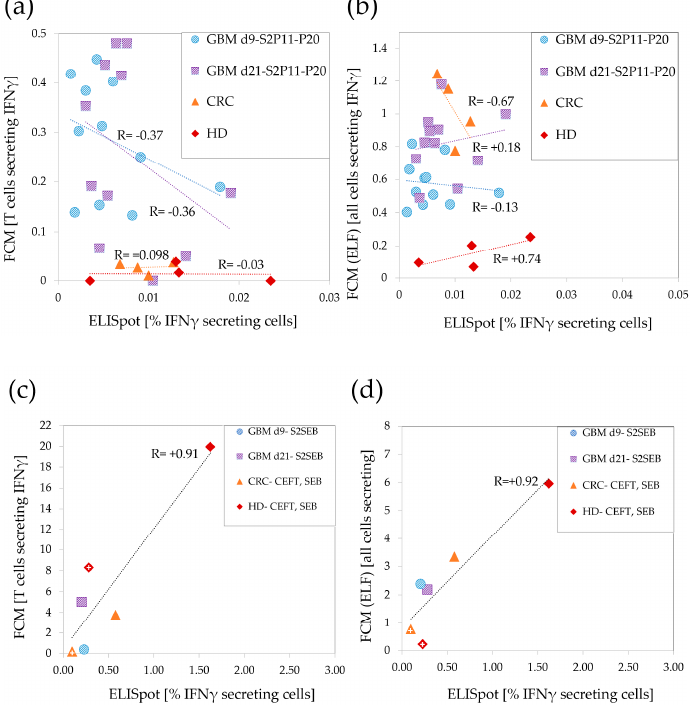
Figure 3. Correlation between ELISpot-measured responses to parallel FCM-measured ones: Responses to peptides in set 2 glioma vaccine (set2 peptides 11–20) in two time points (d9, d21), and responses to peptide pools in CRC and HD samples analyzed by FCM and ELISpot. ( a ) Summed CD4+ and CD8+ T-cell responses (FCM) correlated to ELISpot SFU frequencies. ( b ) All IFN γ + responsive cells (FCM-ELF) correlated to ELISpot SFU frequencies. FCM ( c ) and FCM-ELF ( d ) correlations to ELISpot used to monitor responses to stronger antigens: CEFT and SEB. For each set of samples, Pearson’s correlation coefficient (R) was calculated, and a trend line was added .